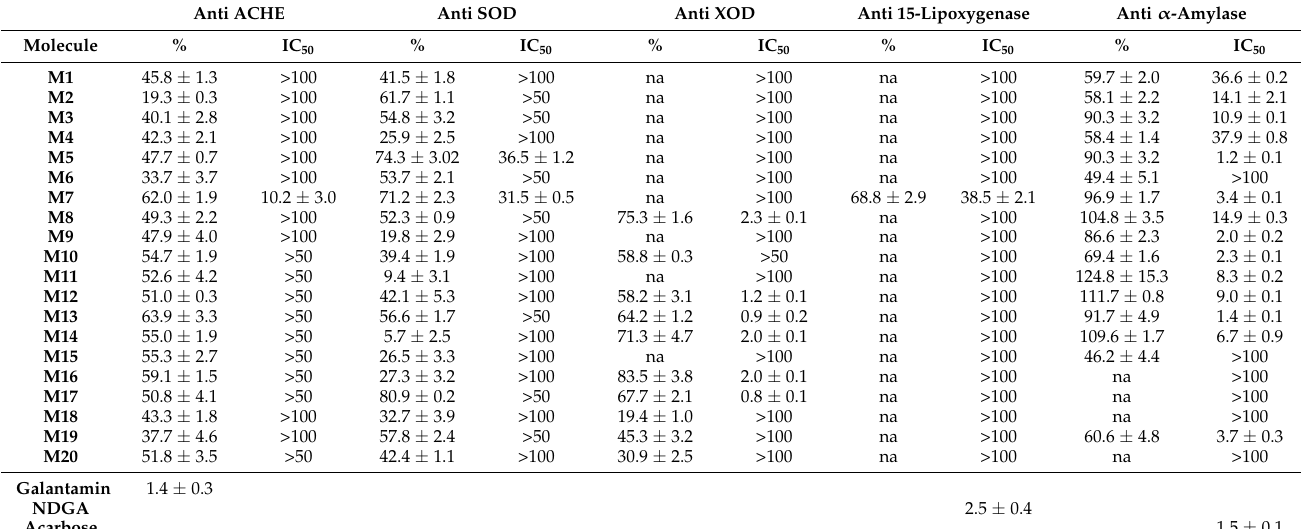
Table 3. Biological activities of flavones at 100 µ M (%) and IC 50 values. na: not